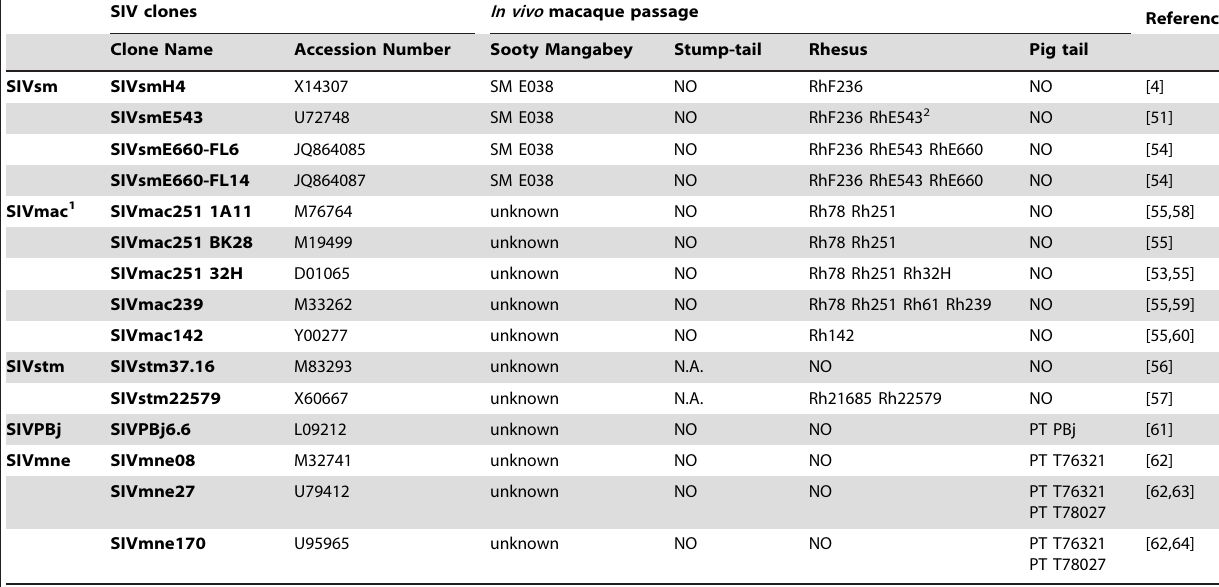
Table 3. Passage history of SIV clones.